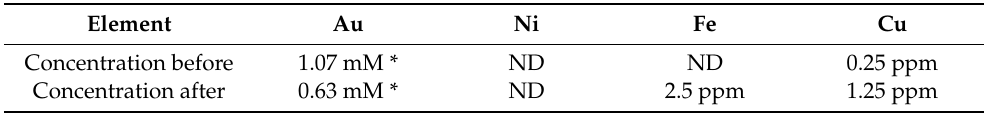
Table 5. Chemical composition by MP-AES analysis of the HAuCl 4 before and after the evapora- tion cycles. Element Au Ni Fe Cu Concentration before 1.07 mM * ND ND 0.25 ppm Concentration after 0.63 mM * ND 2.5 ppm 1.25